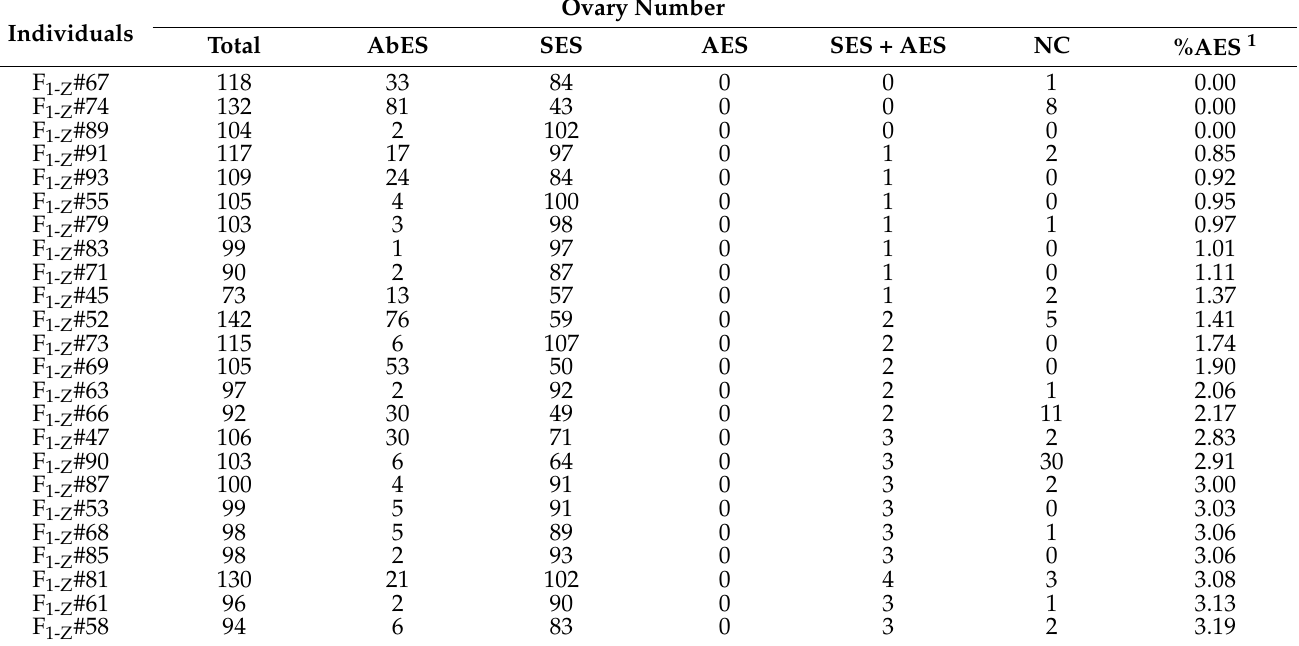
population characterized in Zavalla. 1-Z